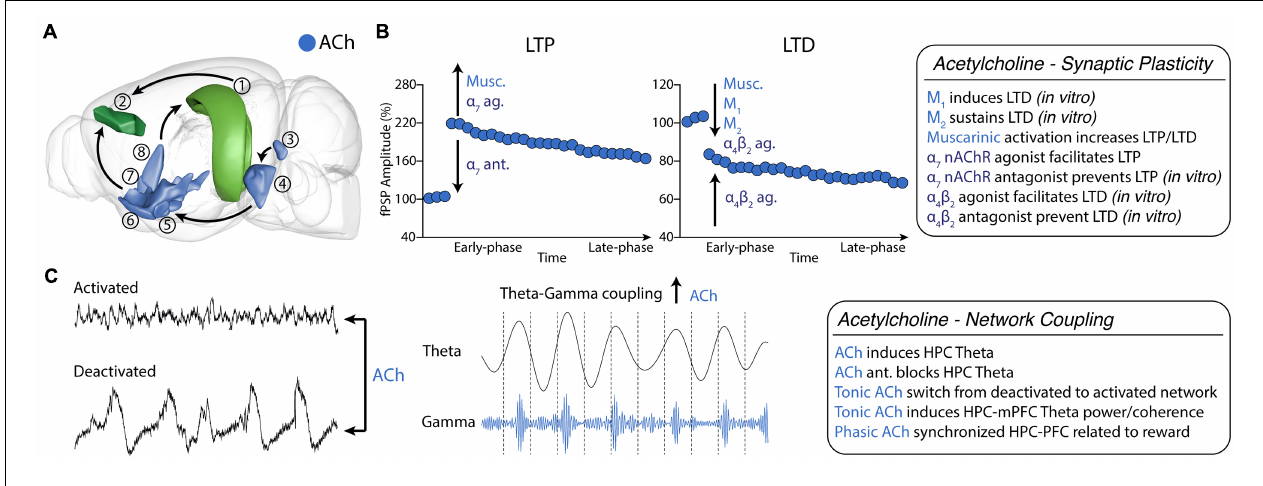
FIGURE 2 | Cholinergic neuromodulation of HPC-mPFC communication. (A) HPC-mPFC pathway and cholinergic circuits. (1) Hippocampus CA1/Subiculum; (2) Prelimbic prefrontal cortex; (3) Laterodorsal tegmental nucleus; (4) Pontine reticular nucleus; (5) Magnocellular nucleus; (6) Substantia innominata ; (7) Diagonal band nucleus; (8) Medial septal nucleus. Blue: main cholinergic anatomical structures (brain sites adapted from the Brain Explorer, Allen Institute). (B) Muscarinic and nicotinic receptor activation bidirectionally affects long-term synaptic plasticity, increasing LTP and LTD induction. (C) Tonic cholinergic modulation is essential to switch from a deactivated state to an activated state. In addition, modulation of muscarinic activation promotes theta-gamma PAC in HPC-mPFC. Ach, Acetylcholine; LTP, long-term potentiation; LTD, long-term depression; ag, agonist; ant.,